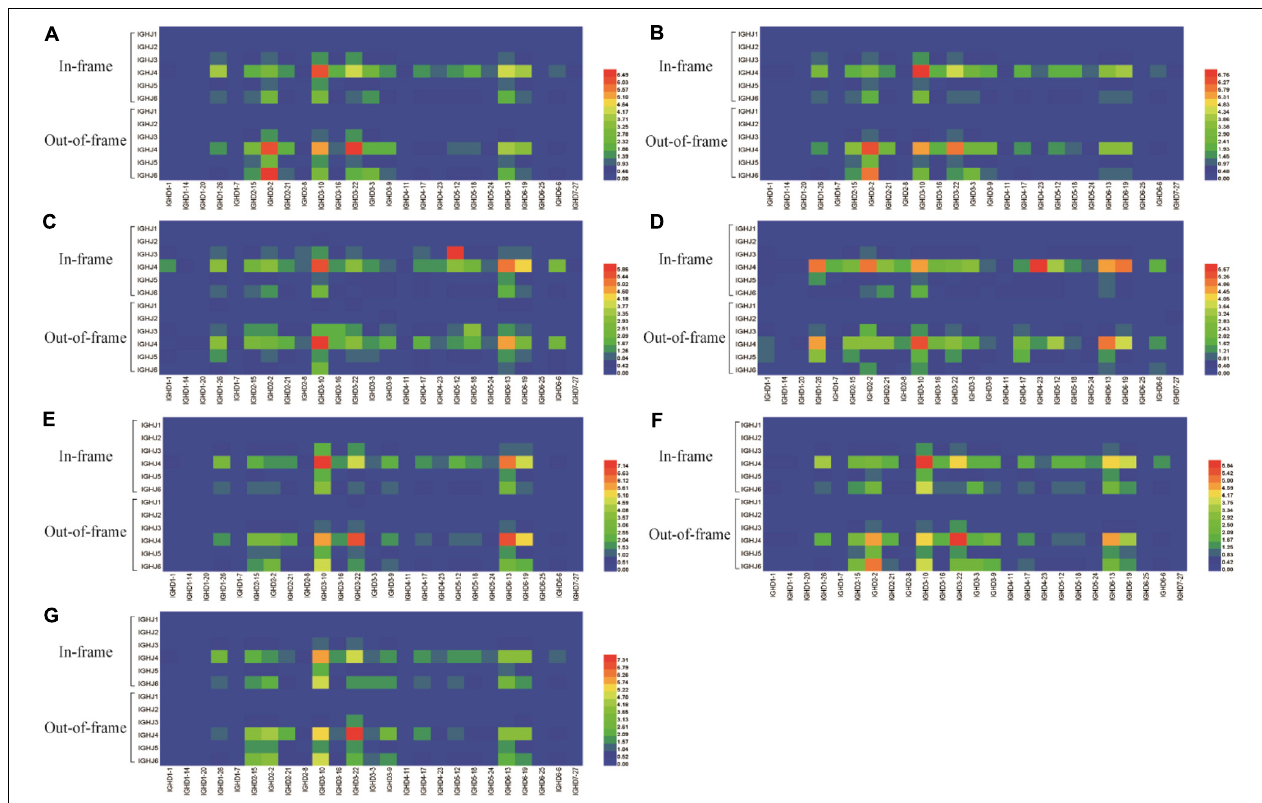
FIGURE 3 | IGHJ-IGHD pairing in the in-frame and out-of-frame BCR-H repertoires from different subjects. (A) IGHJ-IGHD pairing of BCR-H repertoires from 6 Healthy volunteers. (B) IGHJ-IGHD pairing of BCR-H repertoires from public data. (C) IGHJ-IGHD pairing of IgM-H repertoires from volunteers before and after immunization with the HBV vaccine. (D) IGHJ-IGHD pairing of IgG-H repertoires from volunteers before and after immunization with the HBV vaccine. (E) IGHJ-IGHD pairing of BCR-H repertoires from SLE volunteers. (F) IGHJ-IGHD pairing of BCR-H repertoires from breast cancer volunteers. (G) IGHJ-IGHD pairing of BCR-H repertoires from volunteers with a high titer of HbsAb.